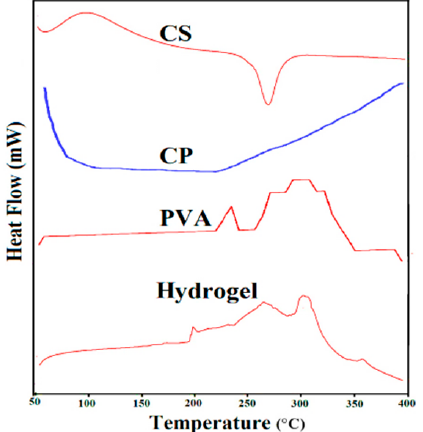
Figure 5. DSC of CS, CP, PVA, and CS/CP/PVAcPAa hydrogel.